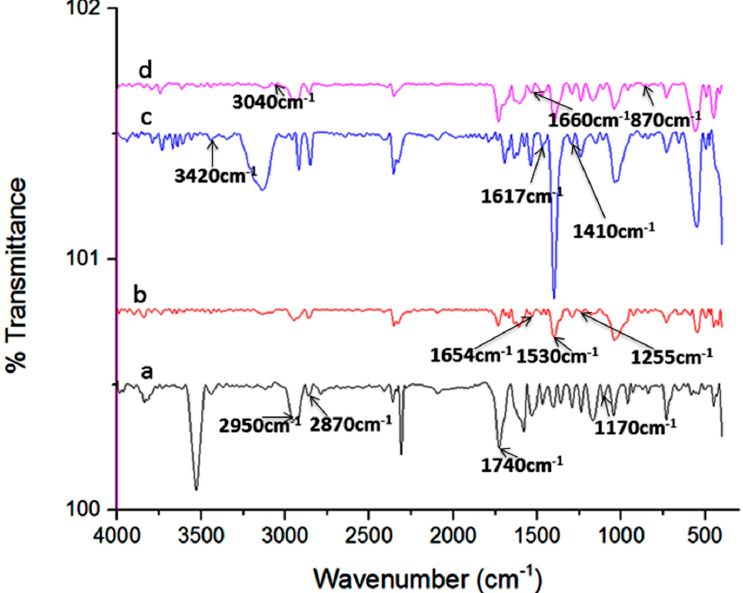
Figure 3. Fourier transforms infrared spectroscopy (FT-IR) study of ( a ) Polycaprolactone (PCL); ( b ) Polycaprolactone/silk fibroin (PCL/SF); ( c ) Polycaprolactone/silk fibroin/hyaluronic acid (PCL/SF/HA) and ( d ) Polycaprolactone/silk fibroin/hyaluronic acid/minocycline hydrochloride (PCL/SF/HA/MH) micro/nanoparticles.